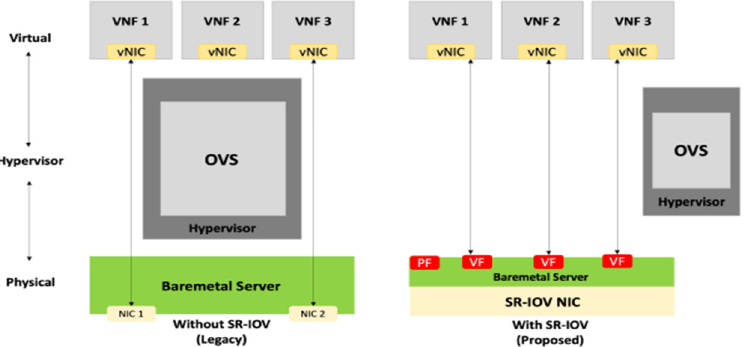
Figure 9. SR-IOV architecture.